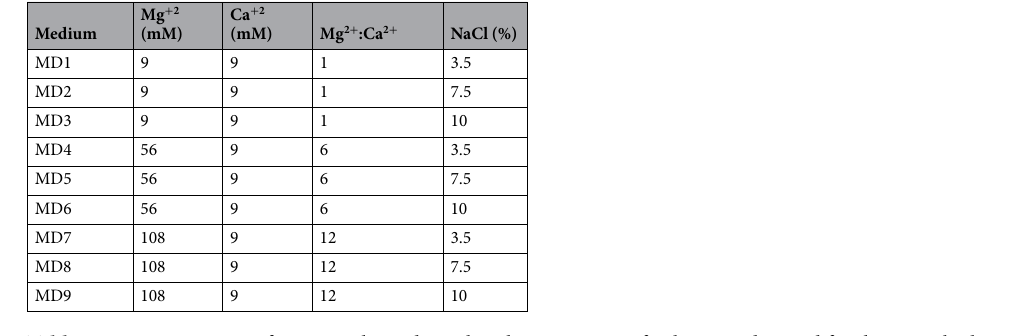
Table 4. Concentrations of acetate salts and NaCl in the nine types of culture media used for the microbial culture